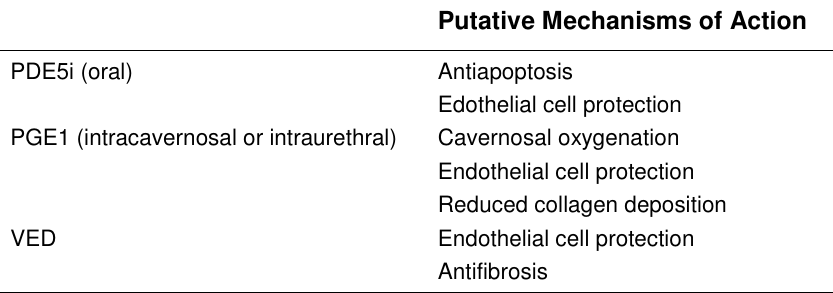
Conventional Therapies Applied for Penile Rehabilitation Putative Mechanisms of Action PDE5i